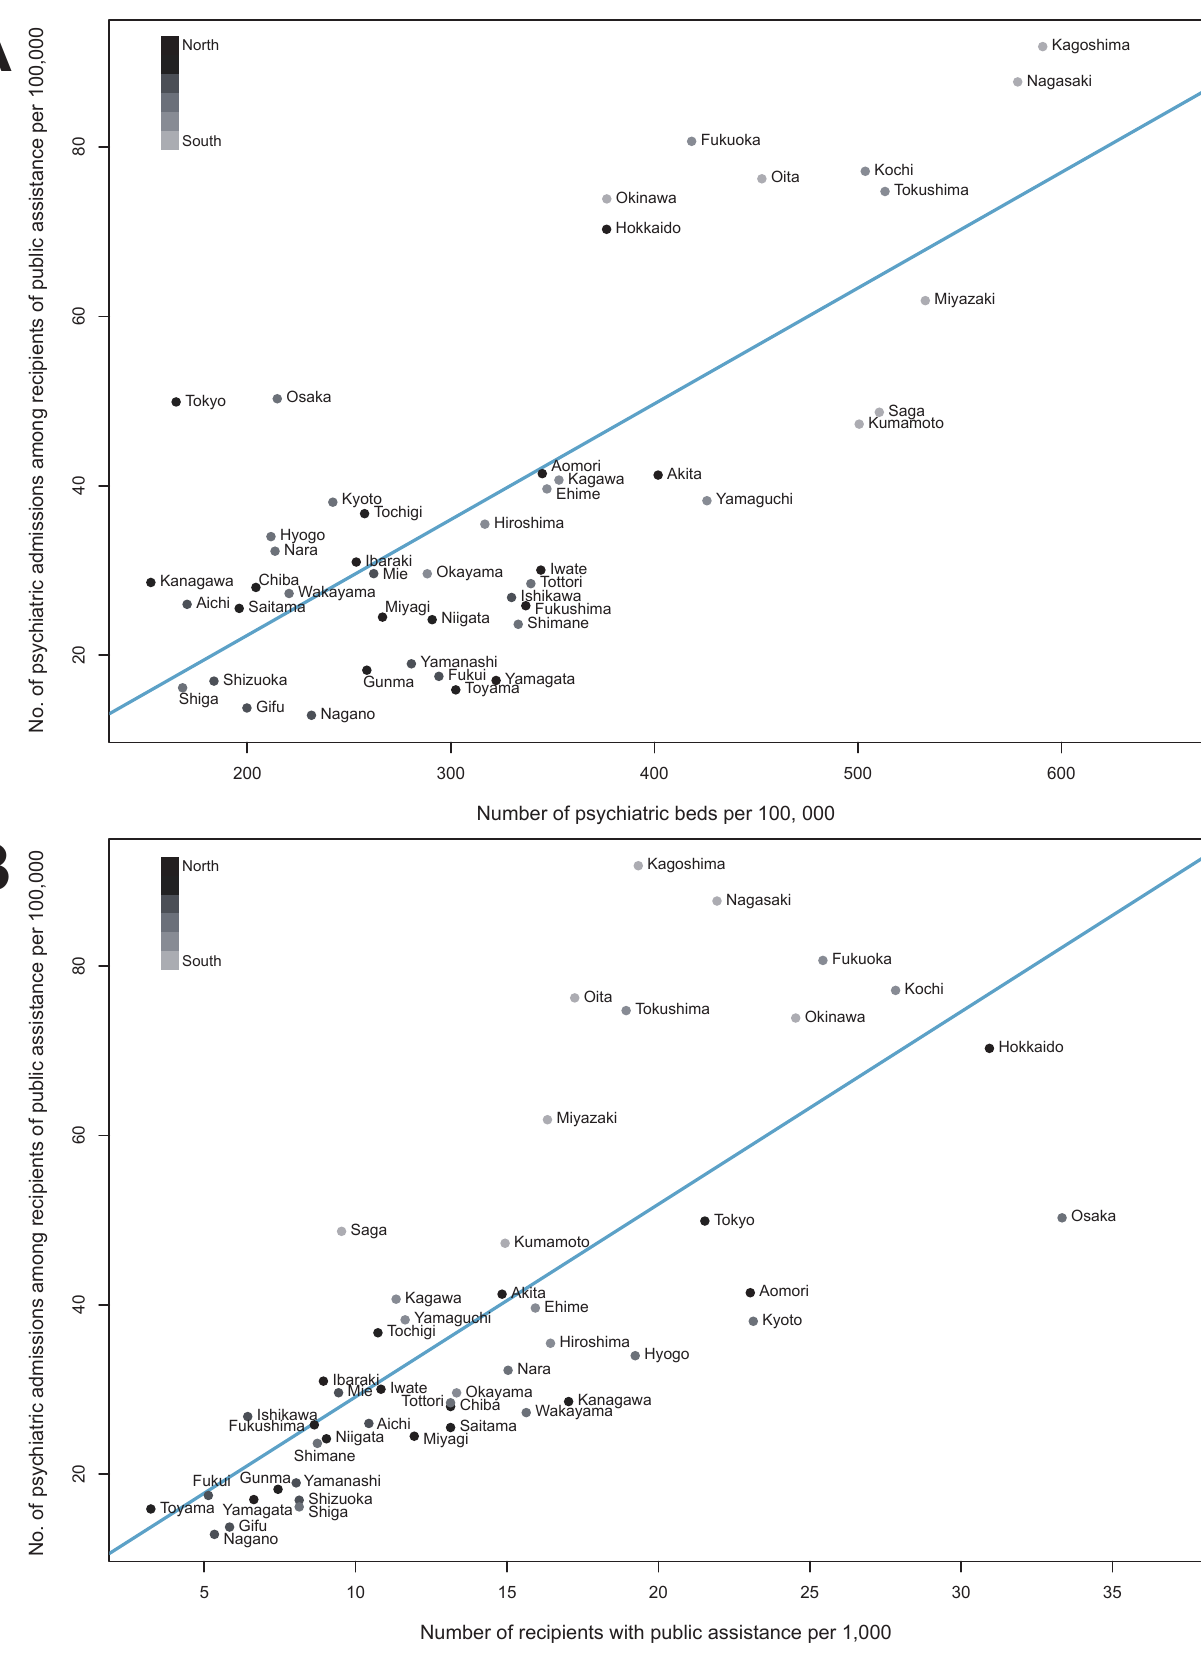
Figure 3. Scatterplot of the age- and sex-standardized number of psychiatric admissions among recipients of public assistance per 100,000 population vs the number of psychiatric beds per 100,000 population (A); and vs the number of recipients of public assistance per 1,000 population